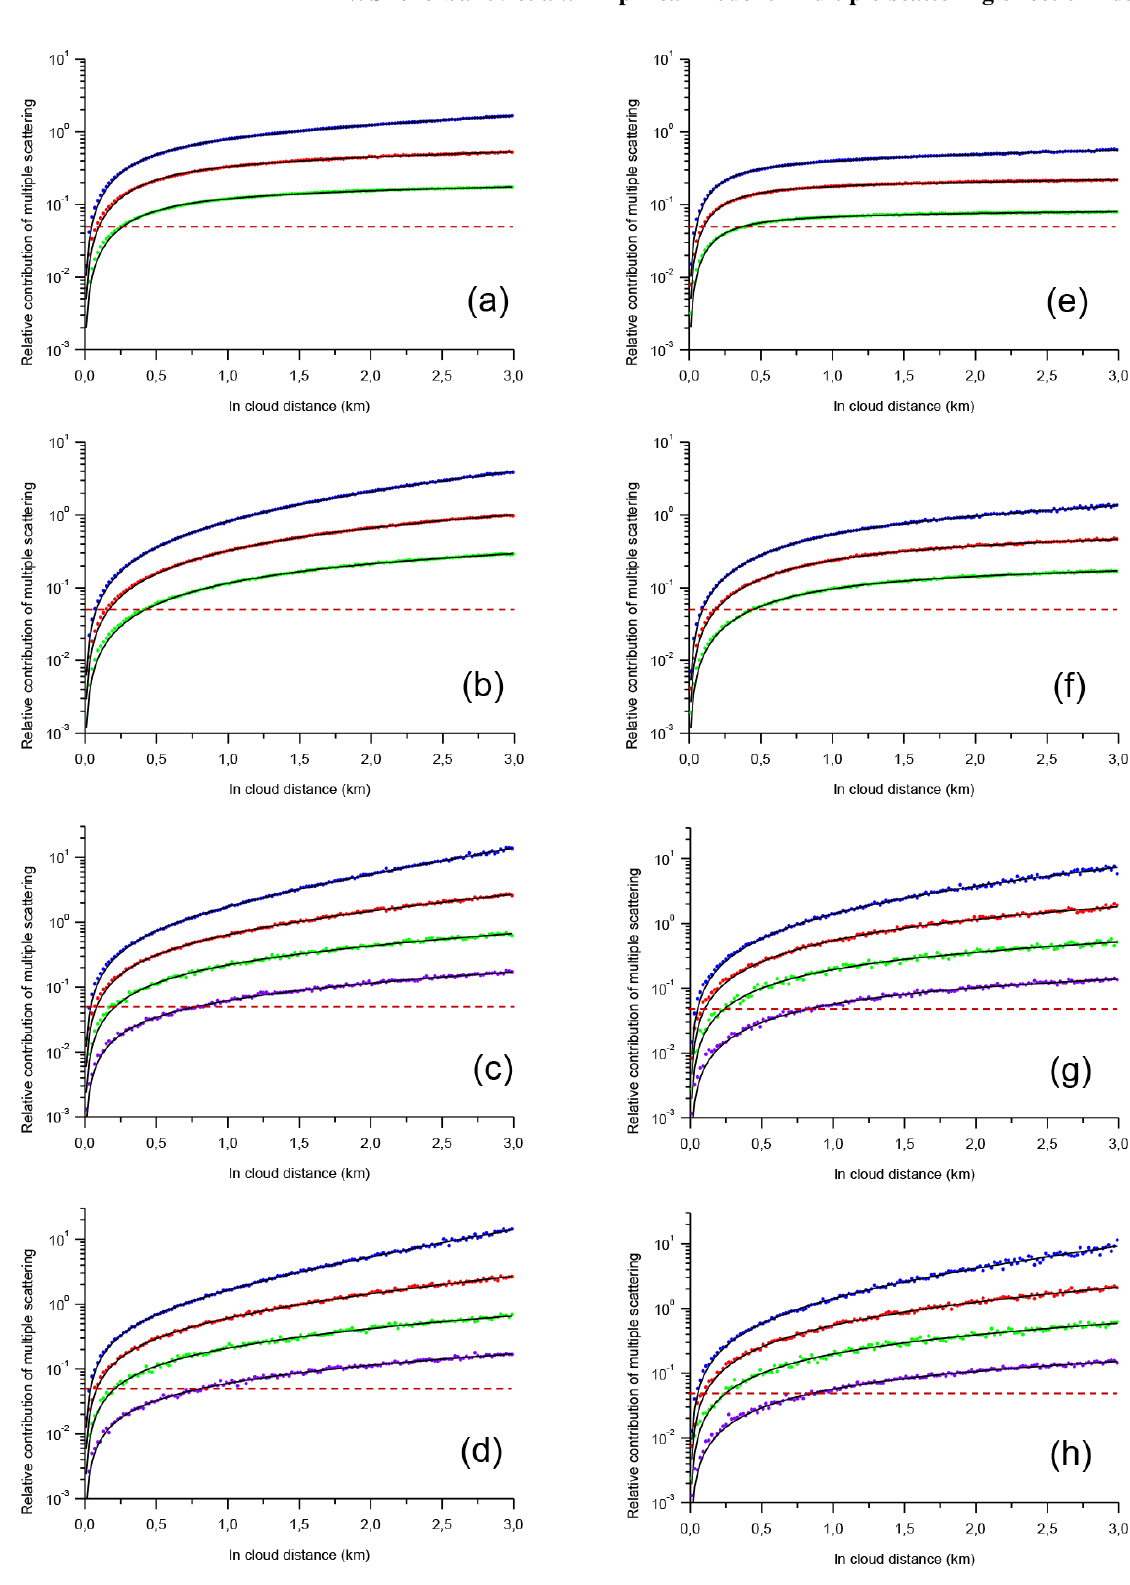
Figure 7. Multiple-scattering contributions R MSto1 to lidar signals. Points – MC simulations, black lines – fitting with the empirical model. The CALIOP configuration (a–d) and the ATLID configuration (e–h) . Coarse aerosol (a, e) , water cloud (b, f) , JS cirrus (c, g) , Ci cirrus (d, h) . The extinction coefficient is 1.0km − 1 (blue points), 0.5km − 1 (red points), 0.2km − 1 (green points), and 0.06km − 1 (purple points). The dashed red lines indicate the 5%